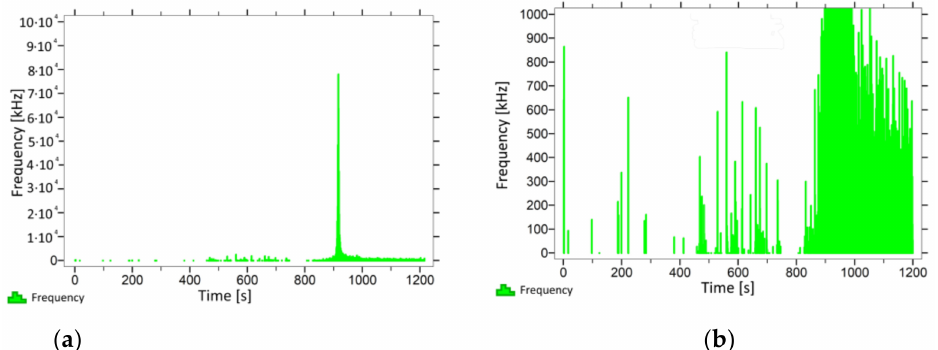
Figure 3. Graph of frequency distribution during the test for a representative sample from series P 2 : ( a ) considering the entire occurring frequency range and ( b ) with details about the frequency range before the moment of breakage.